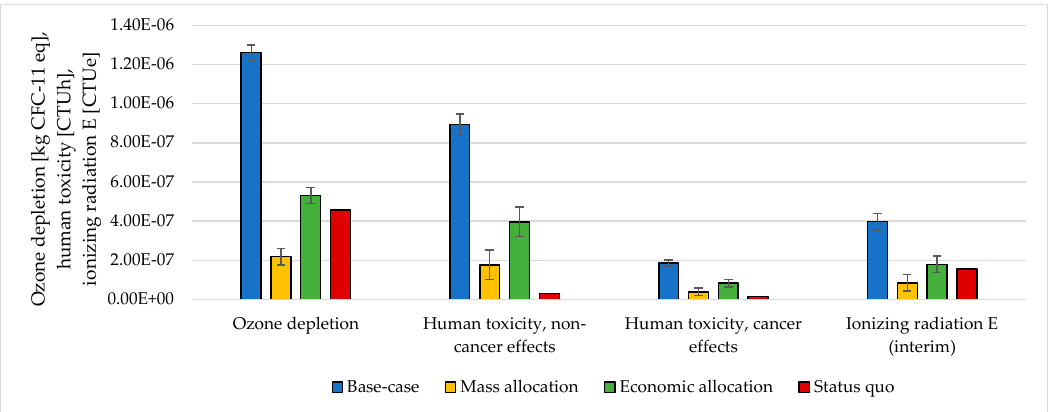
Figure 9. Ozone depletion, human toxicity, and ionizing radiation assessment for 1 kg SNG production under different MU methodologies: base-case, mass allocation, economic allocation, and status quo.